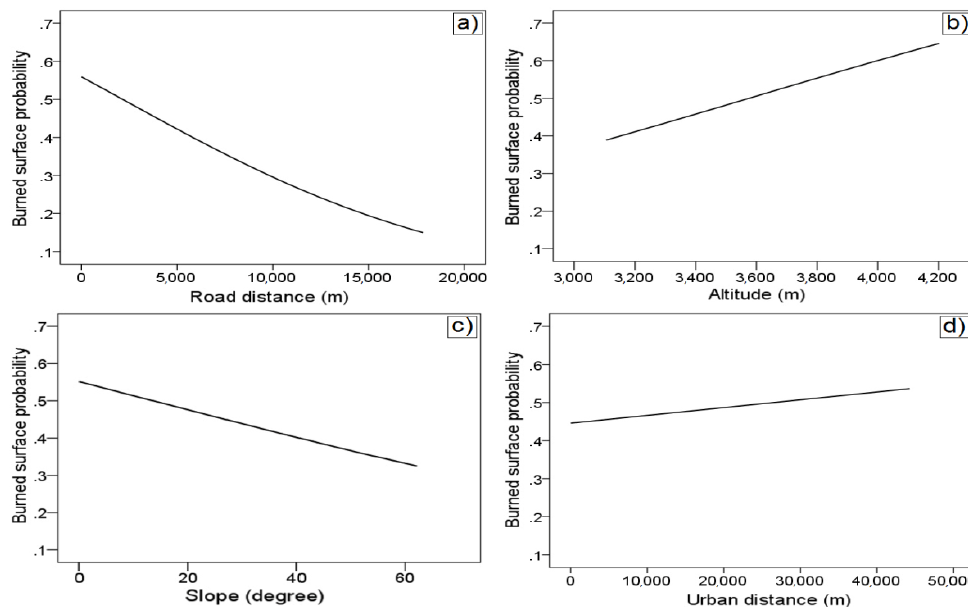
Figure 7. Probability curve modelled as the paramo burned data as a function of the road distance ( a ), altitude ( b ), slope gradient ( c ) and urban distance ( d